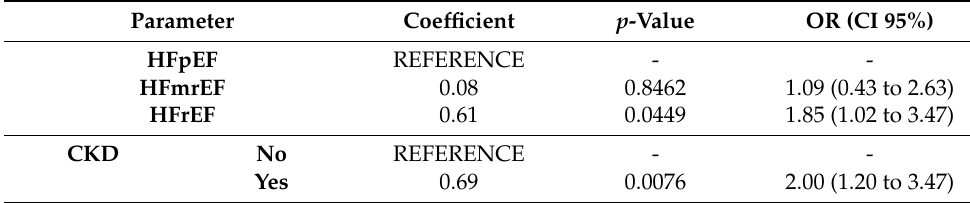
Table 4. Independent predictors for an increased E/e (cid:48) ratio in patients with HF and AF. Parameter